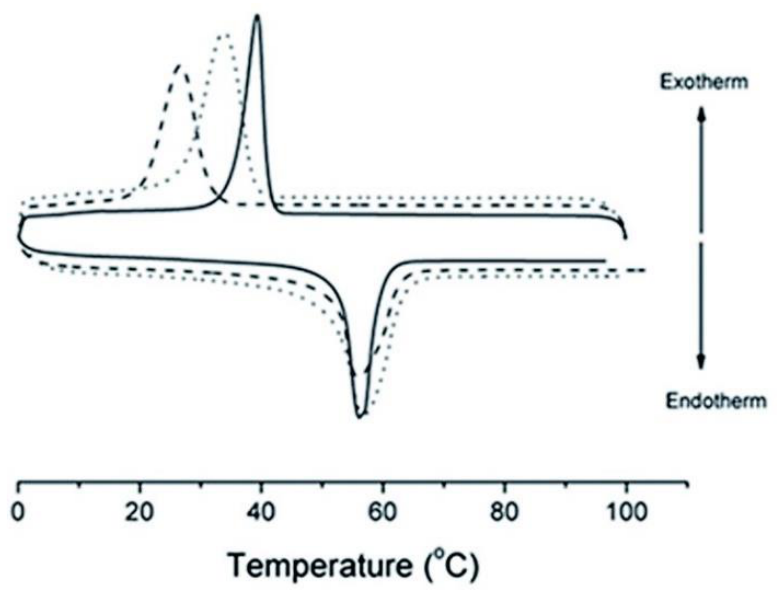
Figure 6. DSC heating and cooling curves for neat PCL (- - -), PCL/rGO (—) composite with 1 wt.% GN loading and PCL/CCG ( . . . ) composite with 1 wt.% loading of CCG [73]. (Adapted with permission from ref. [73]. Copyright 2015 RCS publishing.)